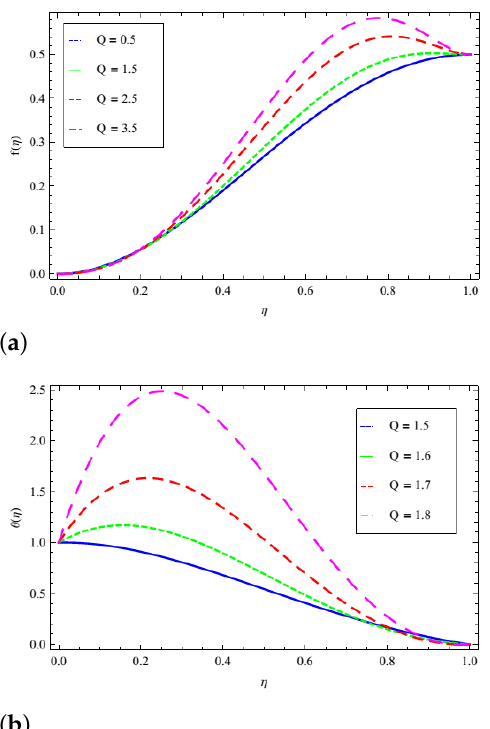
Figure 7. Impact of Q on ( a ) velocity component along x-axis f ( η ) and ( b ) heat distribution variable θ ( η ) for specific values S = − 4, Ha = 1, P r = Sc = K 1 = K 2 = 0.5, L = δ = 2, R = −